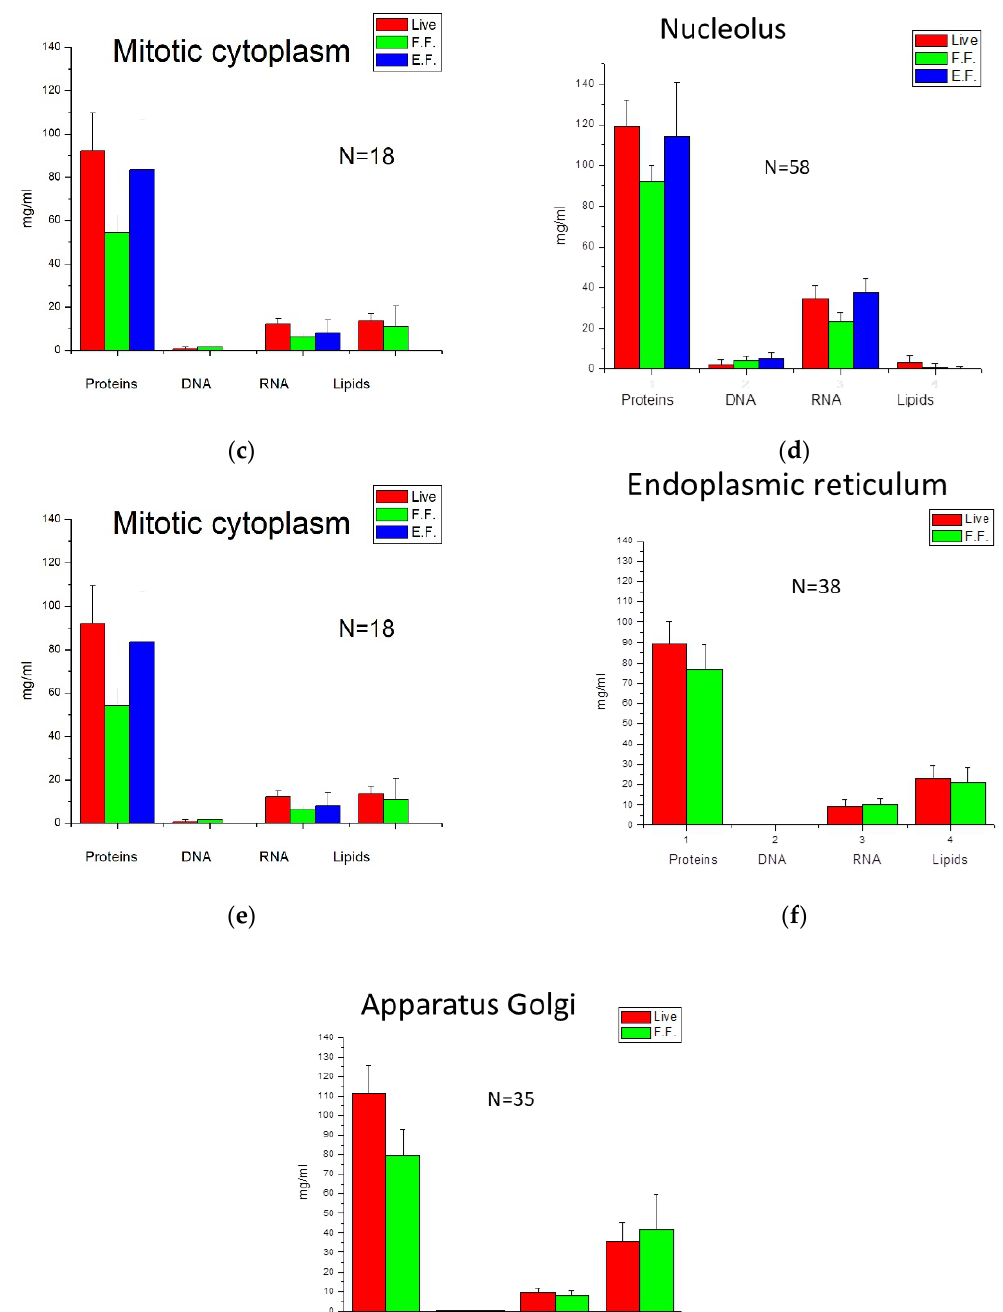
Figure 1. Concentrations of Proteins, DNA, and RNA obtained in different cellular organelles—nuclei ( a ), nucleoli ( b ), mitotic cytoplasm ( c ), mitotic chromosomes ( d ), mitochondria ( e ), endoplasmic reticulum ( f ) and apparatus Golgi ( g )—in live and fixed cells. Abbreviations: E.F.—fixed by ethanol, F.F.—fixed by formaldehyde. N shows the number of measured organelles. Error bars show cell-to-cell variations of concentrations.